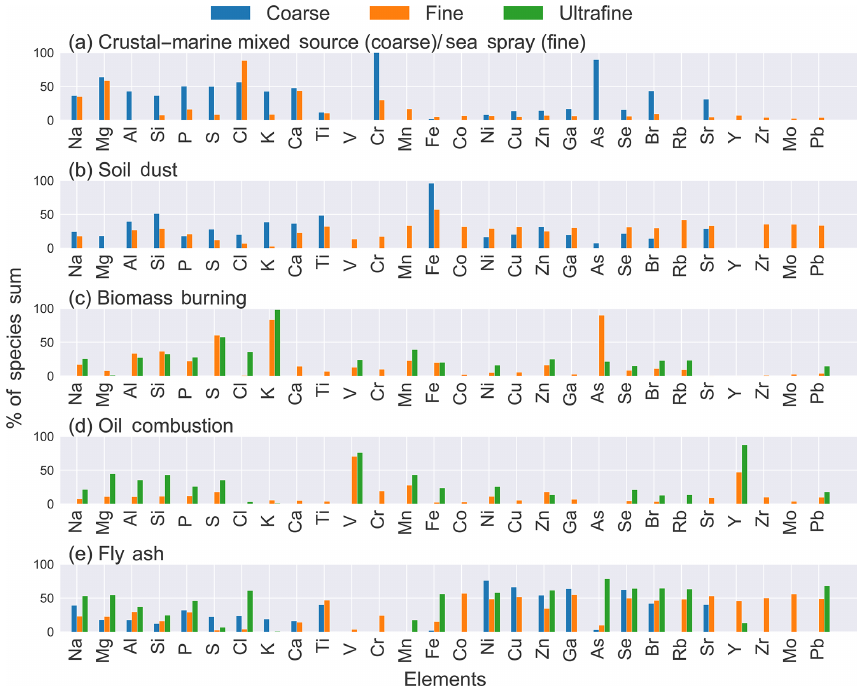
Figure 6. PMF source profiles across different size ranges displayed by percent of species sum for (a) crustal–marine mixed source, (b) soil dust, (c) biomass burning, (d) oil combustion, and (e) fly ash. Coarse: stage 1–3 (1.15–10µm; blue); fine: stage 4–6 (0.34–1.15µm; orange); ultrafine: stage 7–8 (0.10–0.34µm;